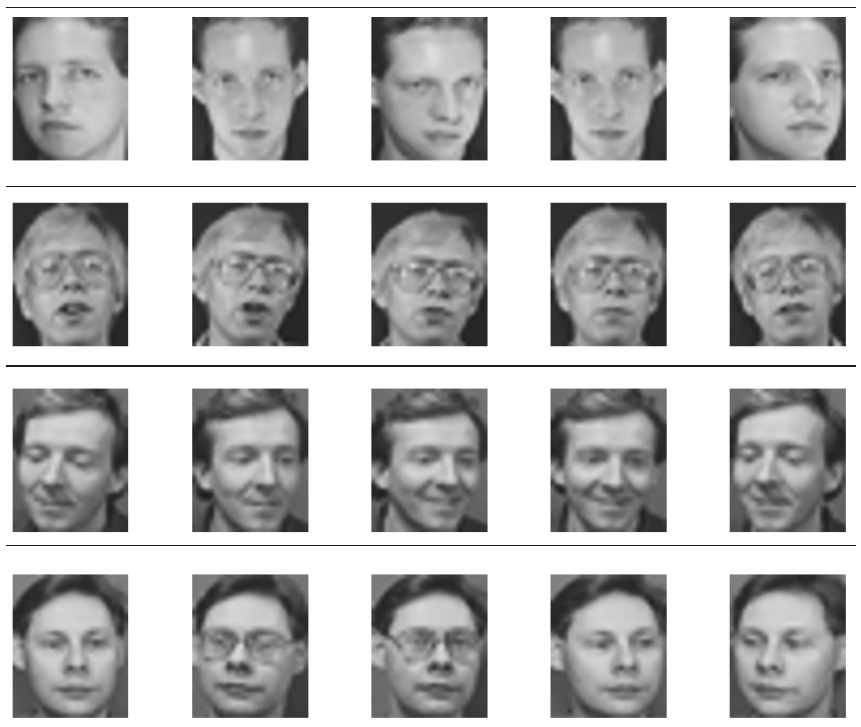
Figure 3: Dimensions adjusted face images through the size adjustment function of the Microsoft office 2010